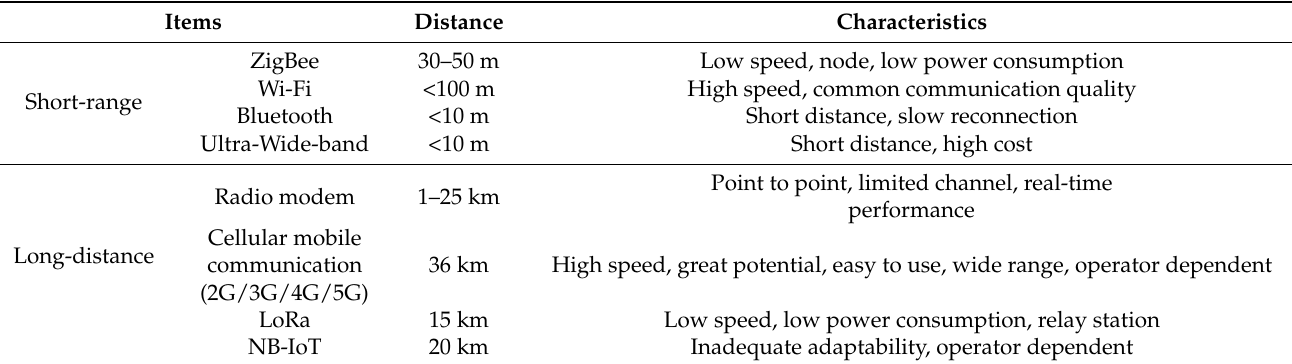
Table 1. Summary of wireless communication